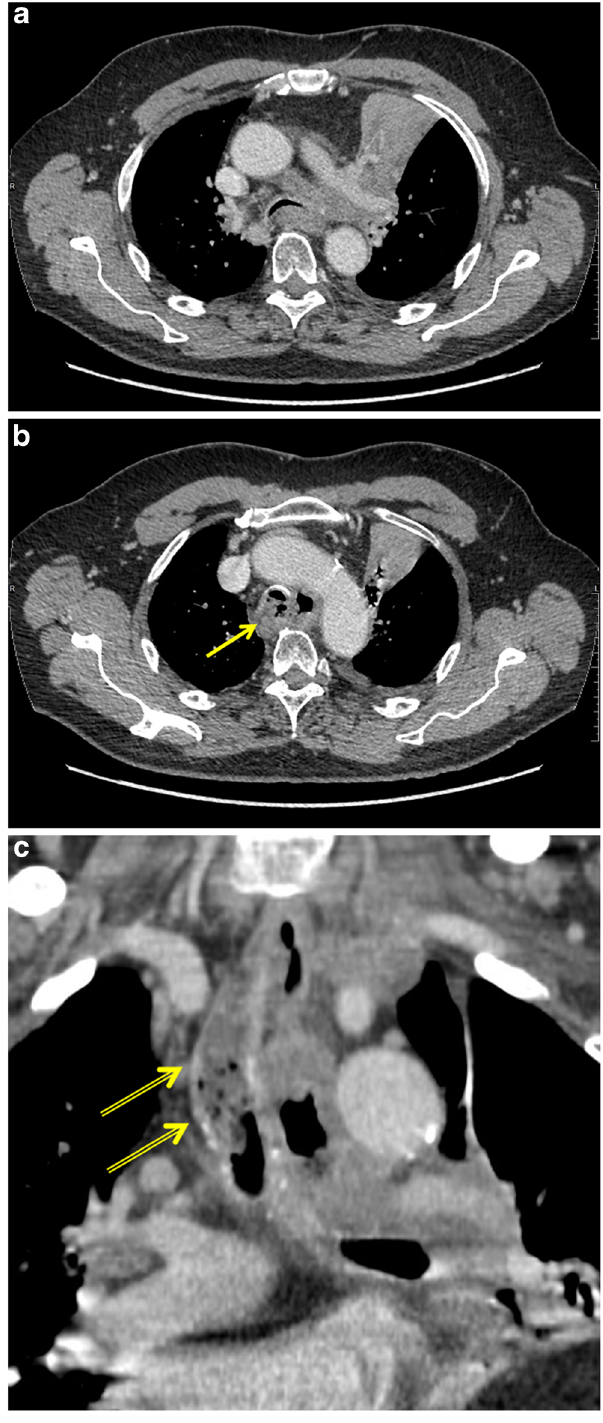
Fig. 7 Tracheo-oesophageal fistula in a 60-year-old man with known stage IV non-small cell lung cancer who presented with a fever and had complaints of dysphagia. a Axial contrast-enhanced CT in mediastinal window setting shows a large left hilar mass encasing the left pulmonary artery with associated retro-obstructive atelectasis of the left upper lobe. Note mediastinal invasion extending to the trachea and oesophagus ( yellow arrow ). b Axial CT image at the level of the aortic arch reveals an extraluminal gas collection adjacent to both oesophagus and trachea. Both the walls of the oesophagus and trachea are thickened at this level with blurring and fatty infiltration of the surrounding fat planes.